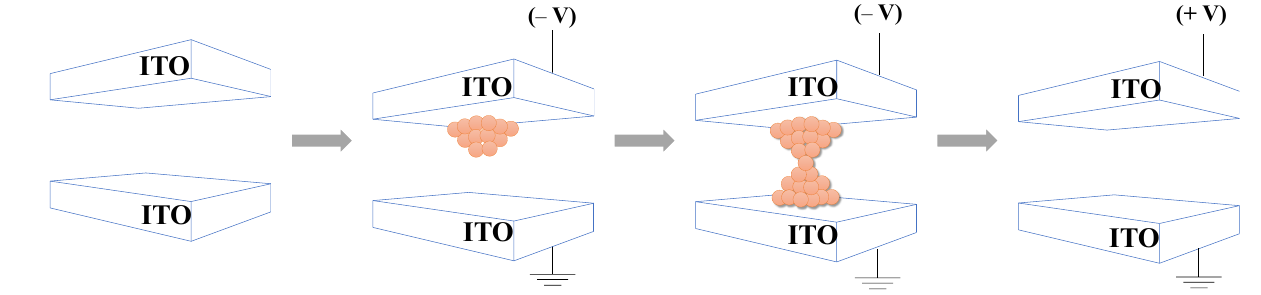
Figure 4. Schematic diagram of switching operation in valence change memory. Partial reset curve occurred at the voltage of 7 V and full reset curve occurred at the voltage of 10 V.